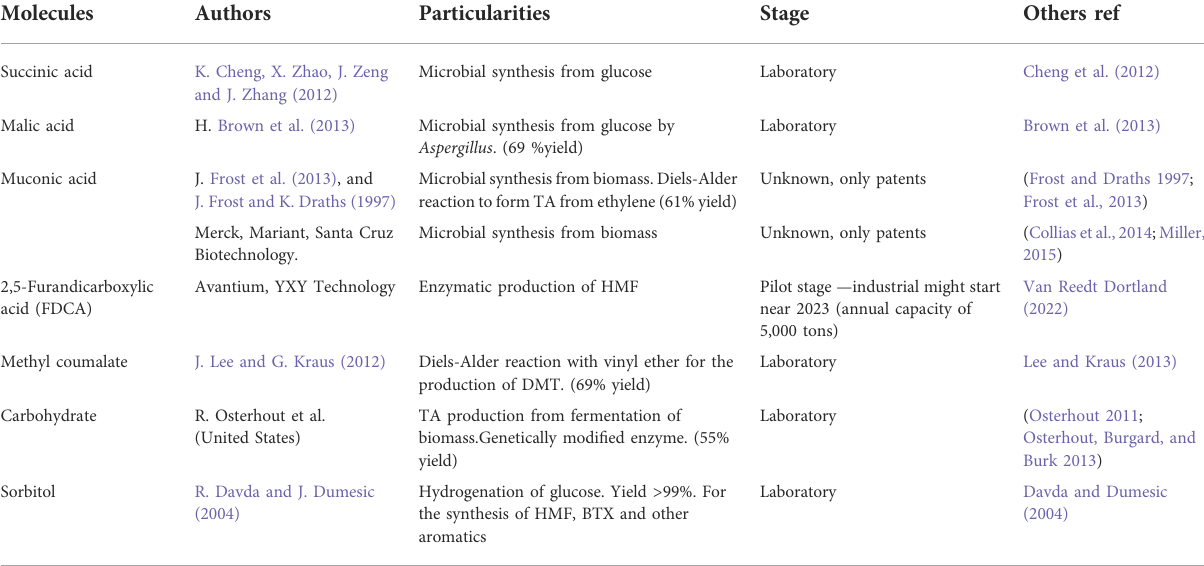
TABLE3Synthesisofthedifferent moleculesused forthe synthesisofTAandexample ofresearch(adaptedfromCollias etal.,2014andMiller,2015).